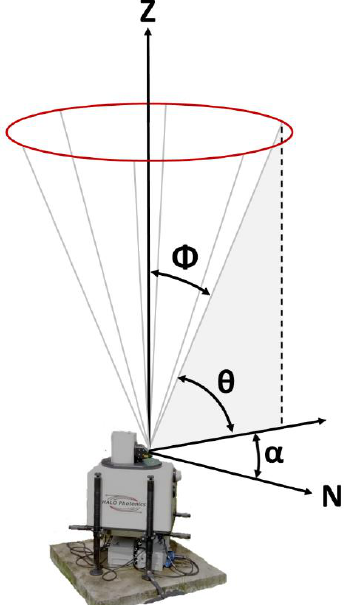
Figure 2. The schematic diagram of both stare and velocity-azimuth display (VAD) scanning methods. The number of bean directions for a VAD scan was 6. The Doppler LiDAR laser beam pointed upward with a constant elevation angle θ and a constant angle Φ with respect to the vertical Z. The laser beam rotated around the vertical Z with a constant interval of an azimuth angle α.